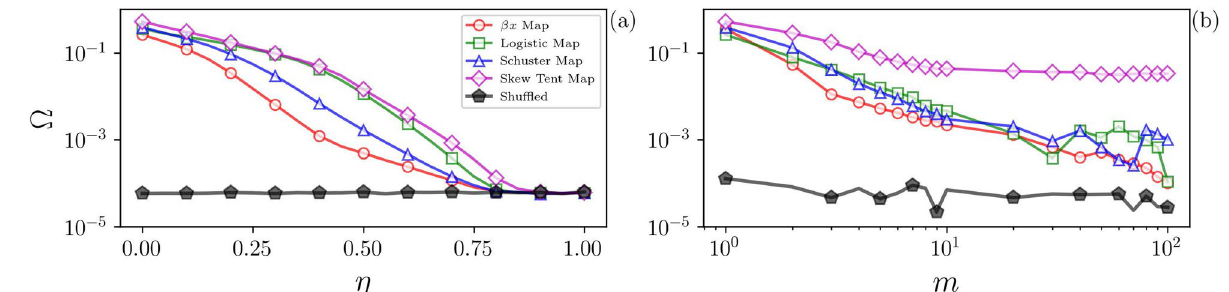
Figure 4. Limits for identifying determinism. Panel ( a ) shows the influence of noise contamination: the quantifier (cid:31) , Eq. (1) is plotted as a function of the level of noise, η , in Eq. (2). We see that as η increases, (cid:31) decreases, but it remains, for high values of η , different from the value obtained from shuffled data (black pentagons). Therefore, small values of (cid:31) can still reveal determinism in noise-contaminated signals. Panel ( b ) shows the effect of adding several independent chaotic signals: (cid:31) is plotted as a function of the number m of signals added. We see that as m increases, (cid:31) decreases, indicating that the deterministic nature of the signal can no longer be